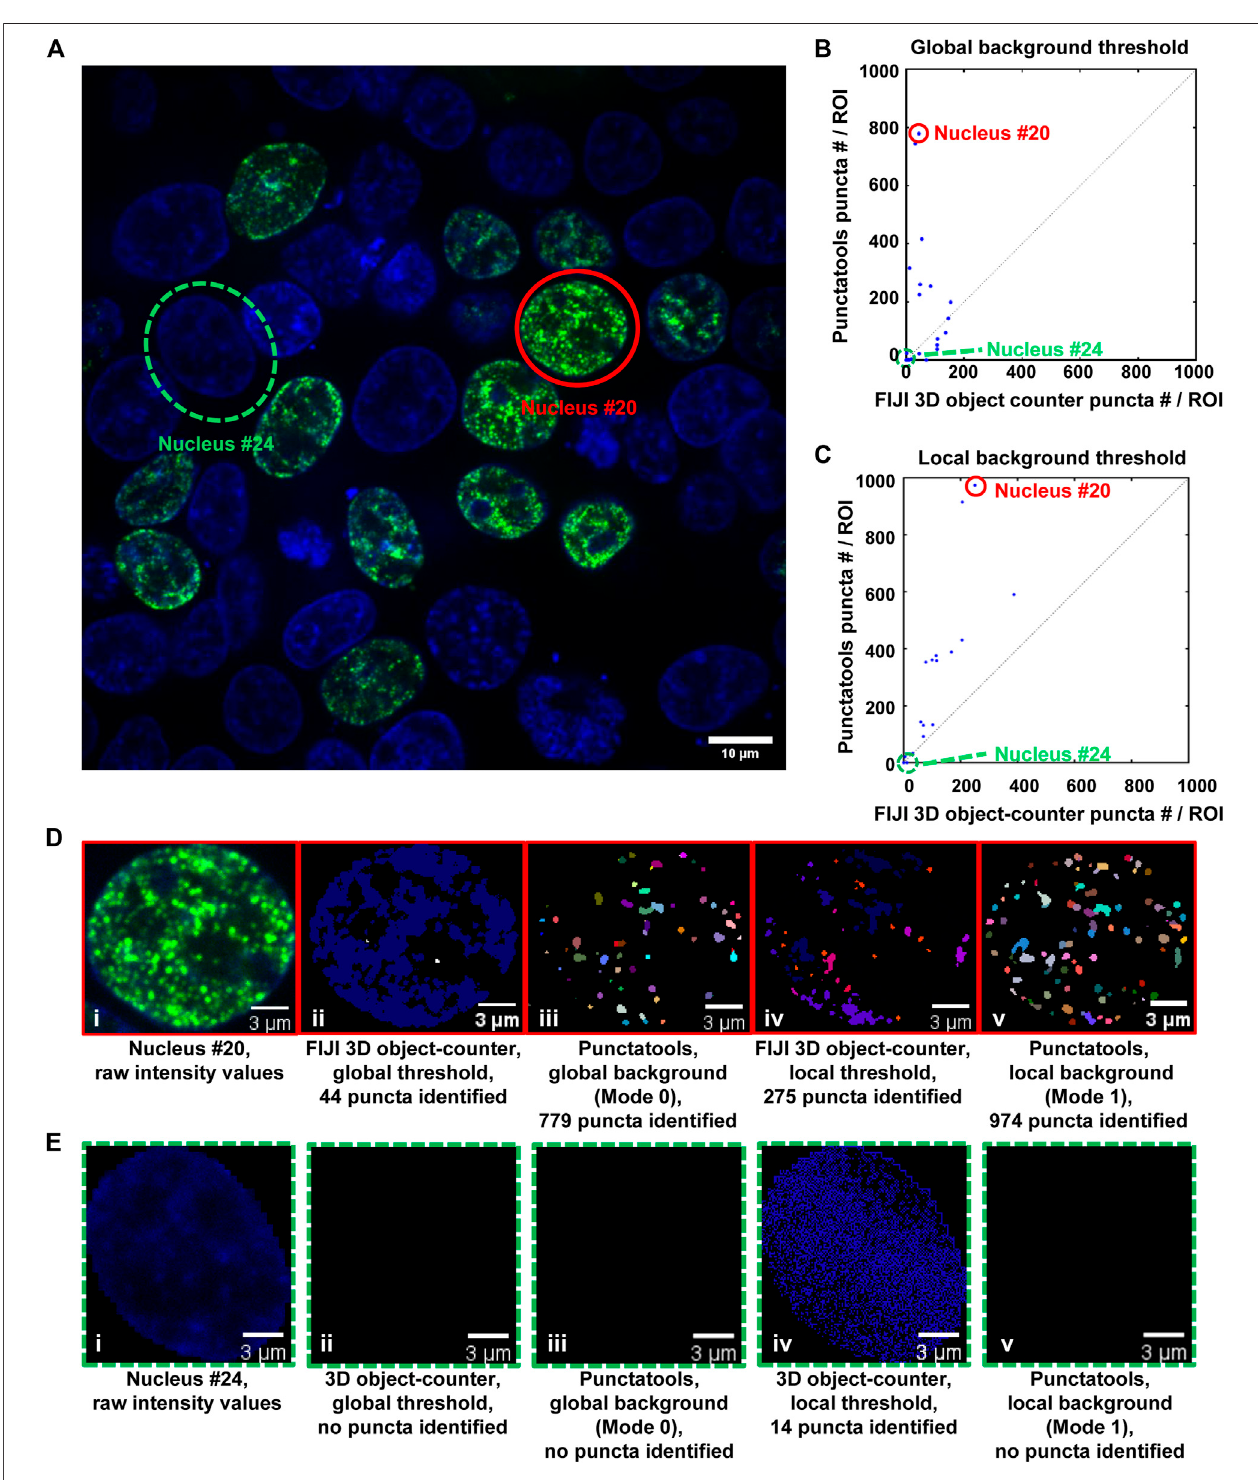
FIGURE 6 | Comparison of puncta segmentation performance: Punctatools versus FIJI 3D object-counter. (A) A single z-layer image of puncta in cells expressing G-NHA9 (the G-NHA9 fl uorescence signals are illustrated in green and those for Hoechst dye are shown in blue); two ROIs (Cells #20 (solid red circle) and #24 (dashed green circle)) in this image were used for the performance comparisons presented in other panels. Cells #20 and #24 display many puncta and no puncta, respectively. Analysisofthe3Dz-stackdatatoquantifypunctafeaturesforindividualROIs(57nucleitotal)resultedindifferentnumbersofpunctabythePunctatoolspipelineand FIJI 3D Object counter differ; in (B) , a constant, global background threshold was used by Punctatools (Mode 0) and the FIJI 3D object-counter and in (C) , the